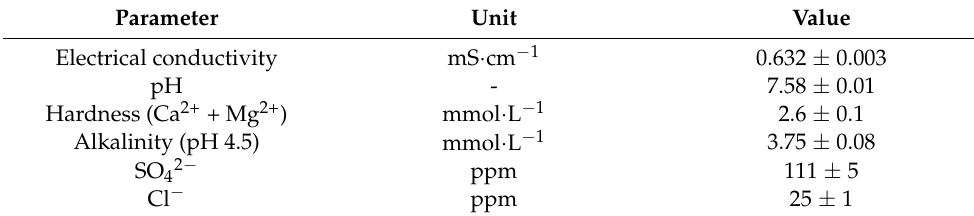
Table 9. The average composition of the feed